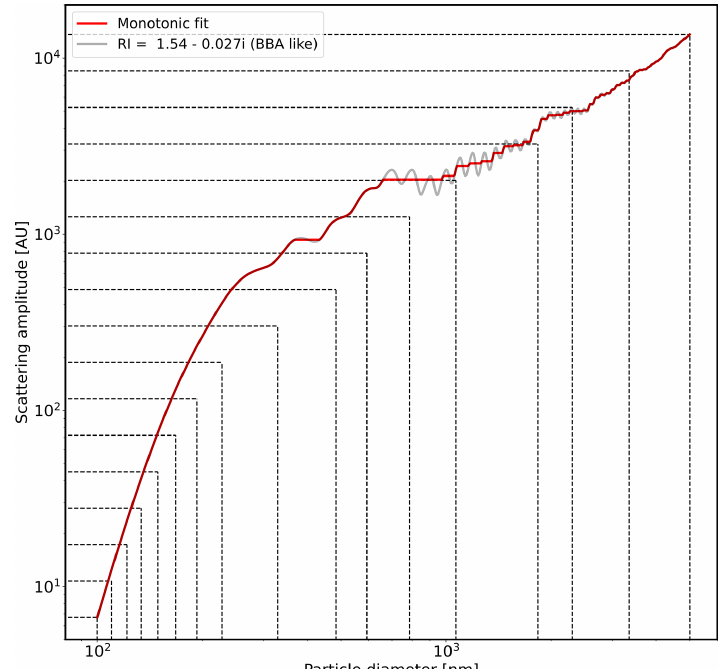
Figure A3. 16 bin boundaries logarithmically spaced in terms of peak value related to particle diameter using the scaled biomass burning curve from Fig. A2. The red line is a monotonically increasing